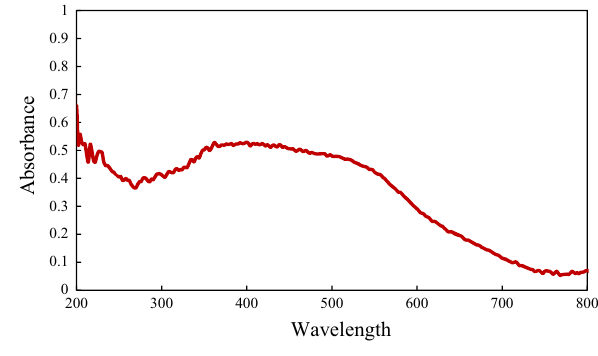
Fig. 5 DRS analysis of Fe +3 –TiO